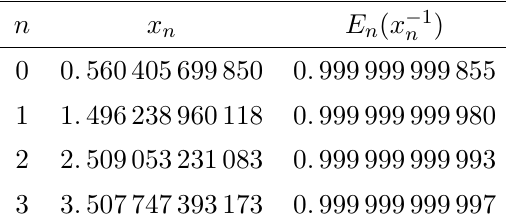
Table 2 . The (cid:12)rst column shows the spectrum of values of x n for the Hamiltonian (4.8), with E = (cid:21) = 1. It is obtained by combining the EQC (4.13) with a numerical solution of the TBA system, involving a discretization with 2 16 points and a cuto(cid:11) at L = 25. The second column shows the values of the energy levels E n ( x (cid:0) 1 ), computed by complex dilatation techniques. n ground state) and of 10 (cid:0) 12 for all the states with n 2. As in any semiclassical (cid:21)